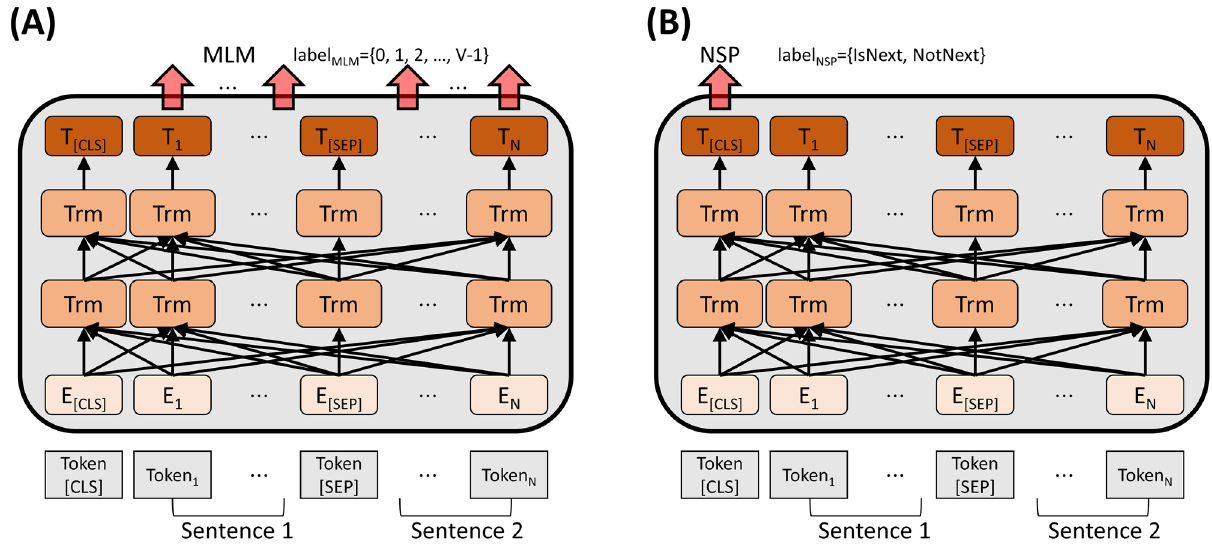
Figure 1. Pre-training process for KM-BERT. A pair of sentences joined by two sentences with special tokens is used as input. ( A ) MLM task. ( B ) NSP